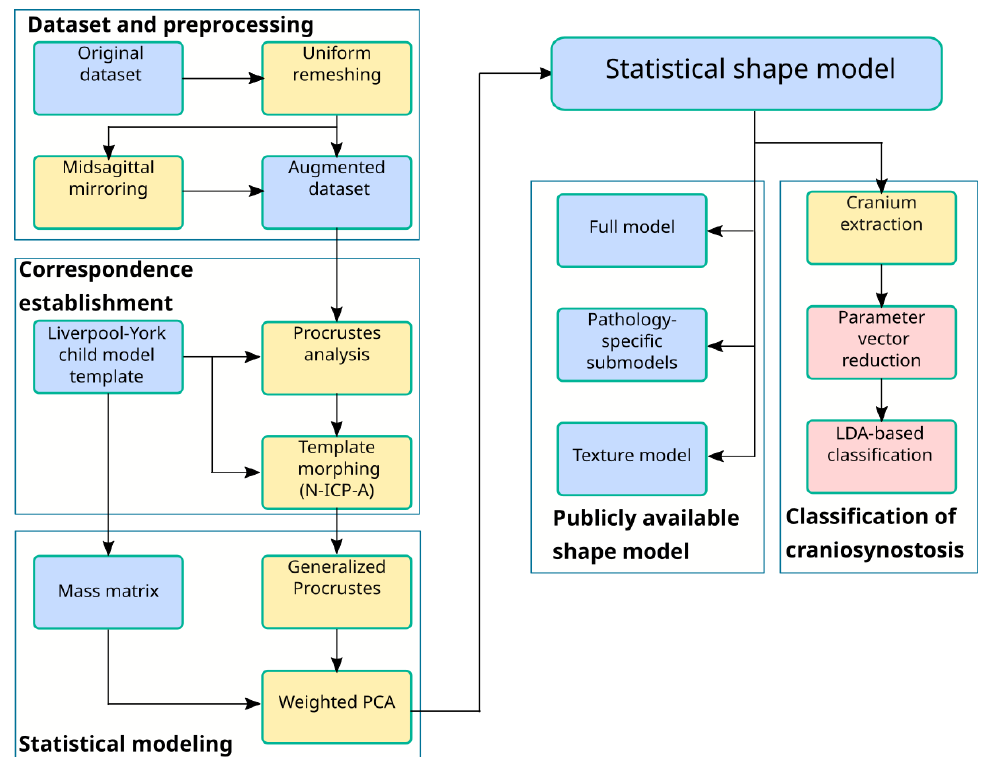
Figure 1. Shape model creation and classification pipeline. Blue: data, yellow: statistical and preprocessing methods, red: classification. Each of the top-level blocks is described